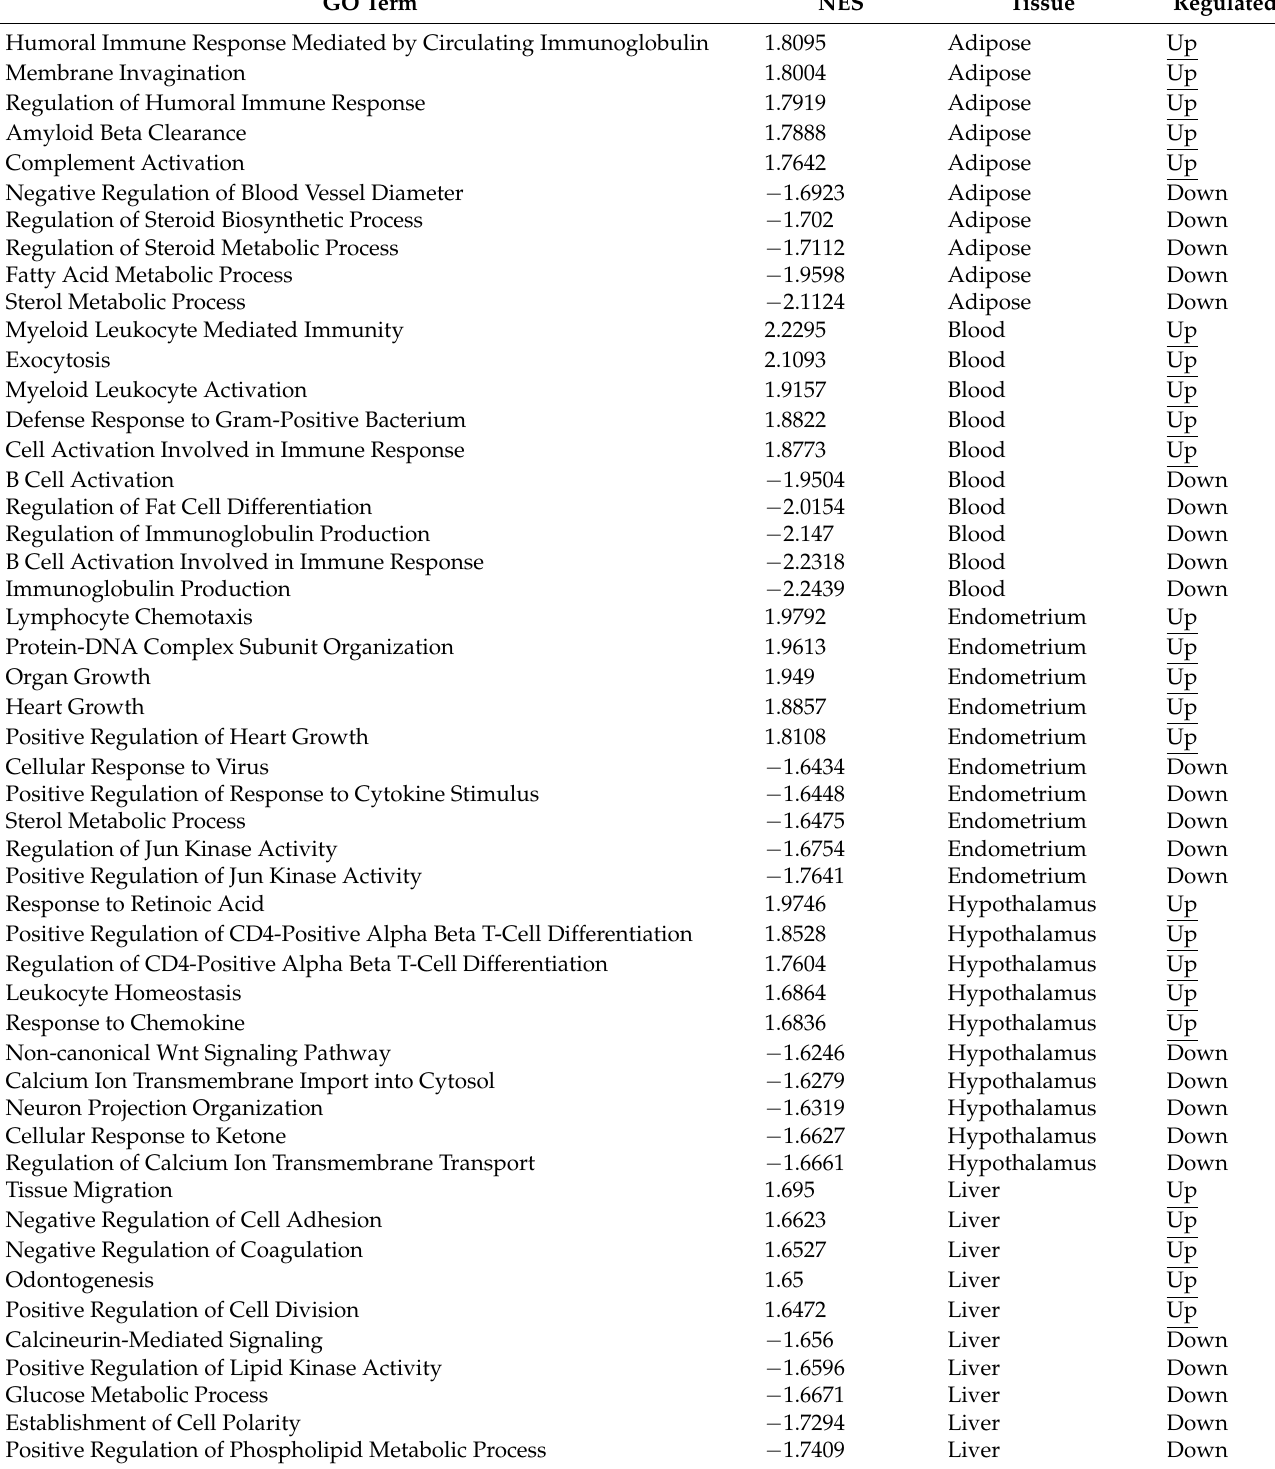
Table 2. The top 5 GO terms of up-regulated and down-regulated processes from every